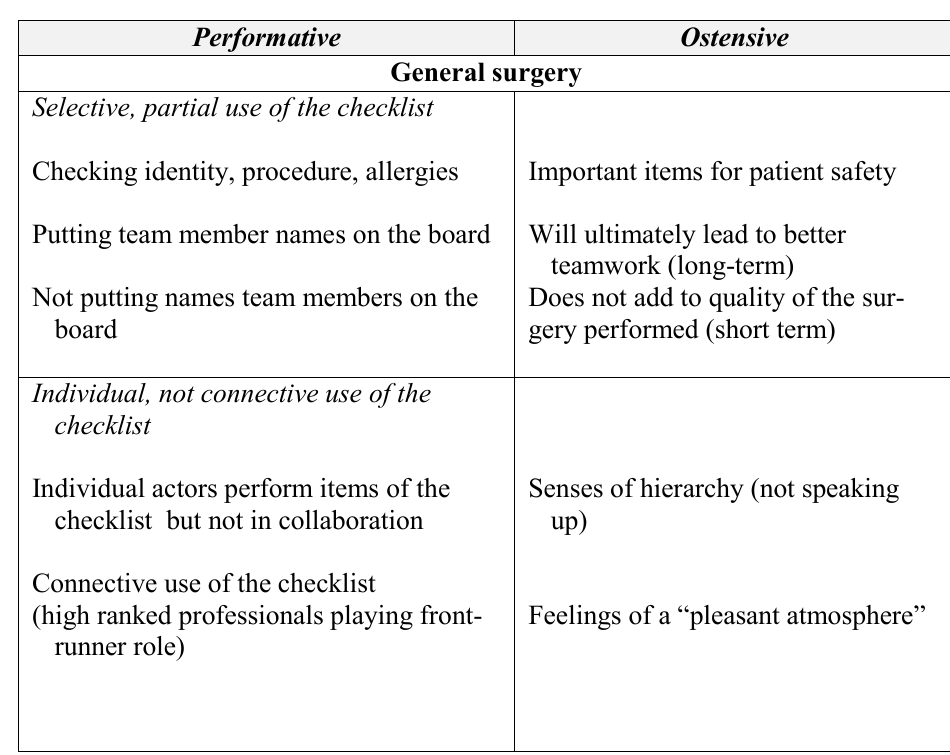
Summary of findings of the interrelation of routine